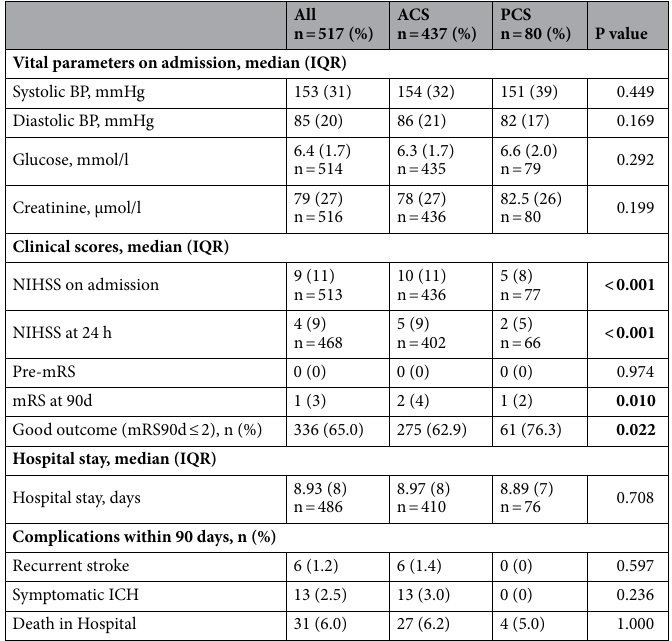
Table 3. Patient characteristics—scores and course of disorder. Scores and course of disorder of all 517 patients and patient groups according to stroke territory, ACS and PCS. Data are expressed as number of patients (n) and percentages or median and interquartile range (IQR). BP indicates blood pressure; NIHSS, National Institutes of Health Stroke Scale; mRS, modified Rankin Scale; ICH, intracranial haemorrhage. P values were obtained according to Mann–Whitney U test, Pearson’s Chi-squared test and Fisher’s Exact test, where appropriate. P values < 0.05 are shown in bold.